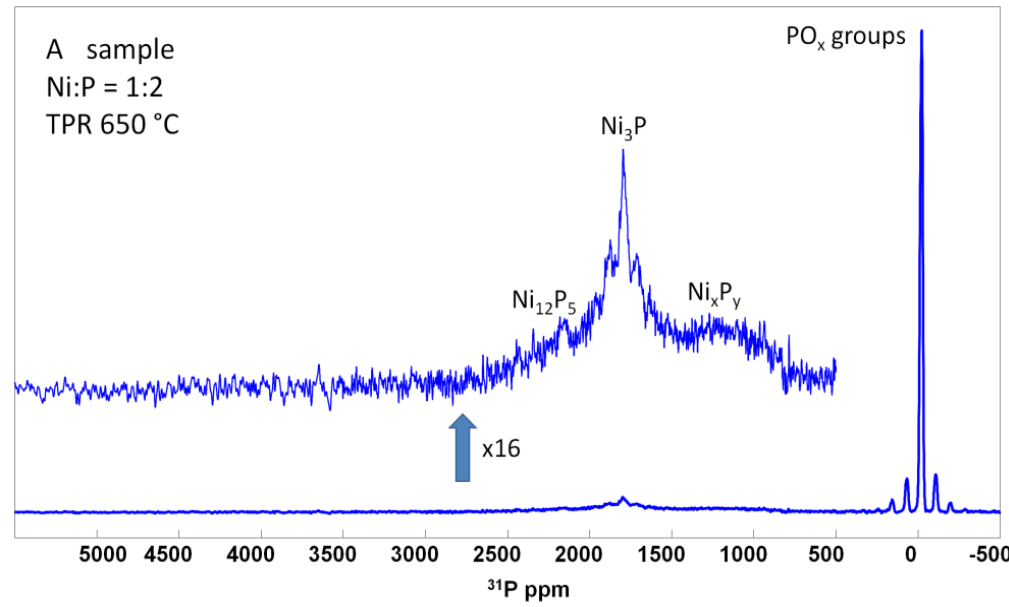
Figure 6. 14 kHz MAS 31 P NMR spectrum of NiP_A/Al 2 O 3 (650) catalyst. The inset shows the “phosphide” region multiplied by 16 for clarity. Catalysts 2018 , 8 , x FOR PEER REVIEW 10 of 23